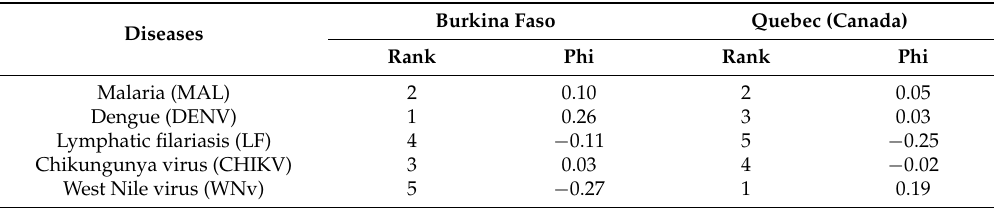
Table 4. Pilot prioritization of climate sensitive infectious diseases by regional